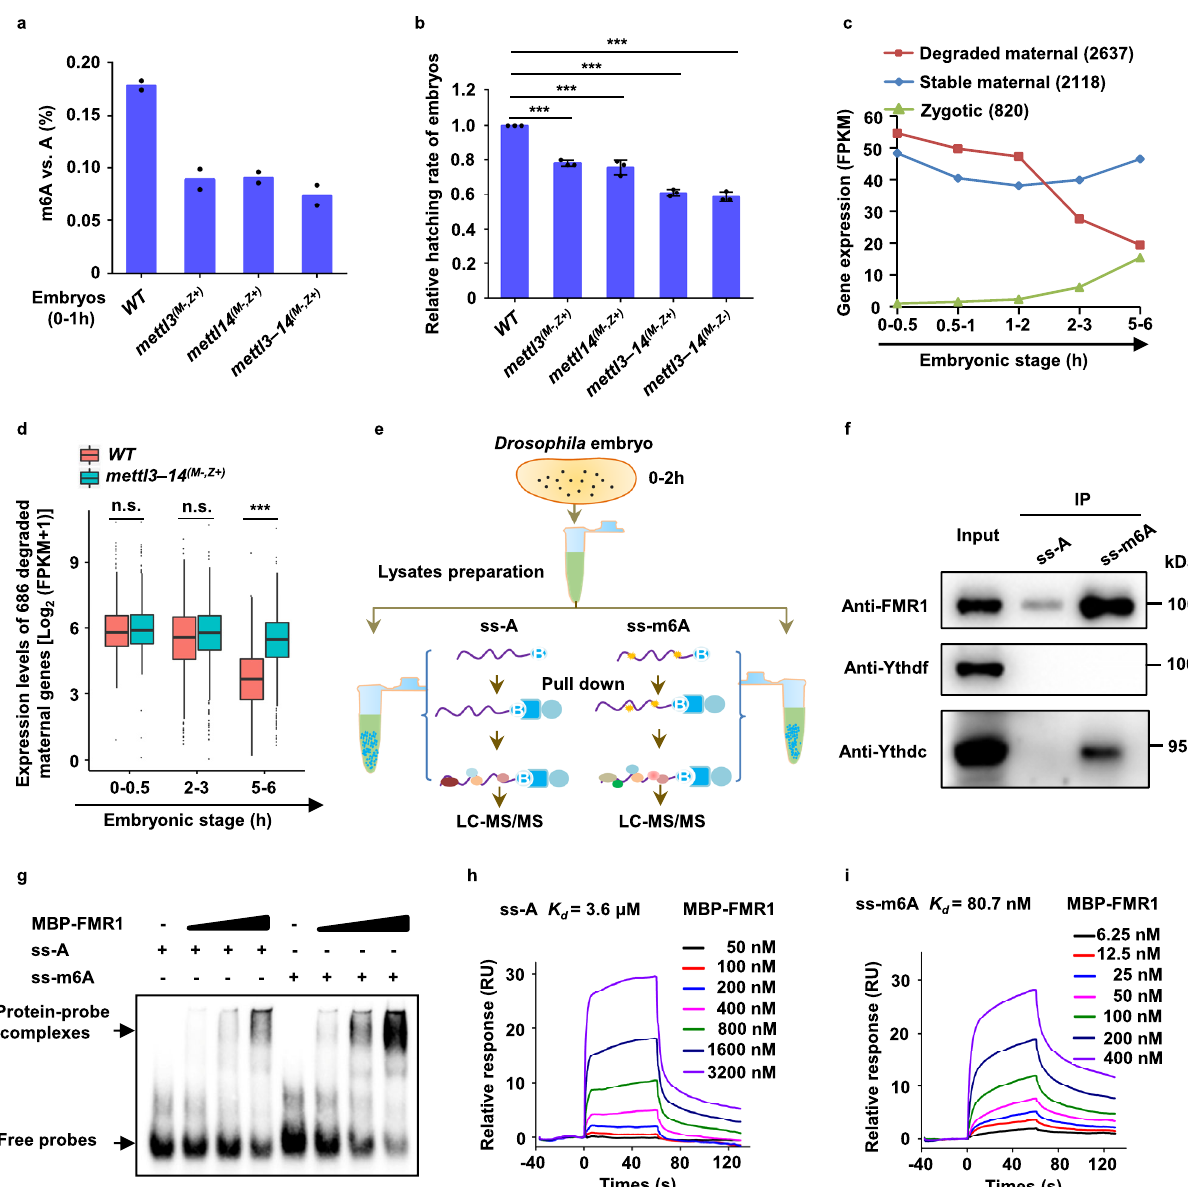
Fig. 1 The m6A modi fi cation regulates maternal RNA decay via preferentially binding m6A-marked mRNAs. a Abundances of m6A on mRNAs from indicated embryos were measured by mass spectrometry. The mole ratios of m6A vs. A are shown on the y -axis. Data expressed as means of two independent samples. b Relative hatching rate of embryos with indicated genotypes ( mettl3 (M − ,Z + ) , P = 2.5e − 05; mettl14 (M − ,Z + ) , P = 0.0005; mettl3 – 14 (M − ,Z + ) , P = 4.6e − 06; mettl3 – 14 (M − ,Z − ) , P = 1.6e − 05). Data expressed as means of three independent experiments. The two-sided Student ’ s t test was used to analyze statistical variance. Error bars indicate mean±SD. *** P <0.001. c Expression pro fi le of clustered gene groups by RNA sequencing. d The degraded maternal mRNAs (686 overlapped mRNAs shown in Fig. S1h) in mettl3 – mettl14 double maternal mutant embryos displayed aberrant stable, when compared to wild-type at the 5 – 6-h stage (0 – 0.5h, P = 0.33; 2 – 3h, P = 0.48; 5 – 6h, P = 3e − 35). P -values were calculated by a one-sided Student ’ s t test. The boxplot shows median (the horizontal line in the box), 1st and 3rd quartiles (lower and upper bounds of box, respectively), minimum and maximum (lower and upper whiskers, respectively). e Schematic for RNA pulldown and proteomics analysis. f Western blot assays were performed by using the anti- Drosophila FMR1, anti-Ythdf, and anti-Ythdc antibodies against complexes puri fi ed by the m6A modi fi ed or unmodi fi ed RNA probes. Representative fi gures of three independent replicates are shown. g EMSAs showing the complex formation of FMR1 with m6A modi fi ed or unmodi fi ed probes. Representative fi gures of three independent replicates are shown. h , i Surface plasmon resonance (SPR) assays of the interaction of FMR1 protein with unmodi fi ed probe ( h ) or with m6A-modi fi ed probe ( i ). Equilibr i um and kinetic constants were calculated by a global fi t to the 1:1 Langmuir binding model. RU resonance units. Source data are provided as a Source Data fi le and Supplementary Data 1 and (EMSA) (Fig. S3b, c). After the validation, we incubated the m6A- labeled RNA probes containing multiple repeated “ recognition modi fi ed or unmodi fi ed RNA probes with cytosolic lysates from early motifs ” , including “ GGACU ” , “ AGACU ” and “ GAACU ” , based on embryos and performed immunoprecipitation experiments followed the m6A recognition motifs reported in the previous studies 32,33 and by mass spectrometry analysis (Fig. 1e). We identi fi ed 12 proteins the motifs identi fi ed in Drosophila embryos (Fig. S3a). These probes that were either preferentially or speci fi cally associated with m6A- were validated by human Ythdf2 (hYthdf2, an “ m6A reader ” modi fi ed RNA probes (Fig. S3d), and found that Drosophila FMRP reported previously) 34 in an electrophoretic mobility shift assay